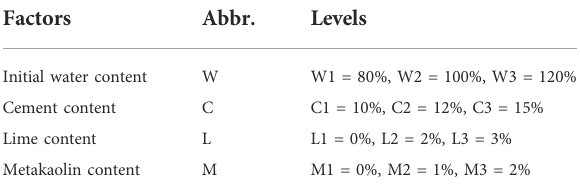
TABLE 3 Factors and levels of the orthogonal test program. Factors